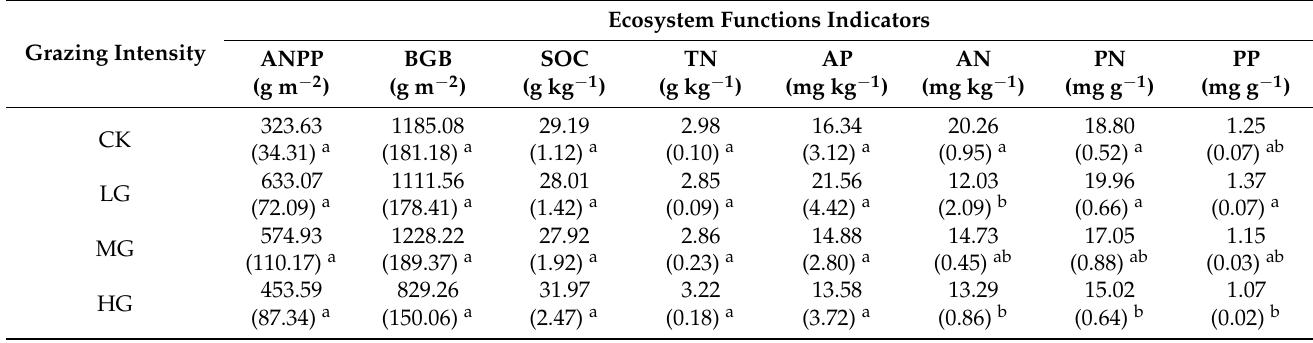
Table 3. Effects of grazing intensity on the ecosystem function indicators.